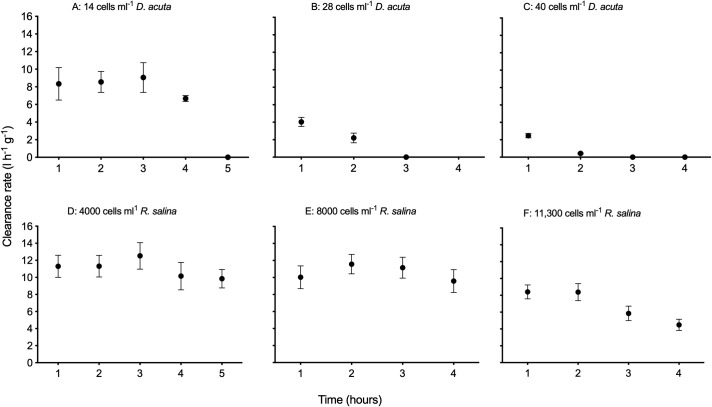
Weight specific clearance rate of Mytilus edulis exposed to Dinophysis acuta and Rhodomonas salina.The weight specific clearance rate (l h-1 g-1) for groups of three Mytilus edulis as a function of time at different algal densities of DST and PTX-containing Dinophysis acuta (A-C) and non-toxic Rhodamonas salina (D-F). Data points refer to average values and error bars to indicate ± 1 SE.